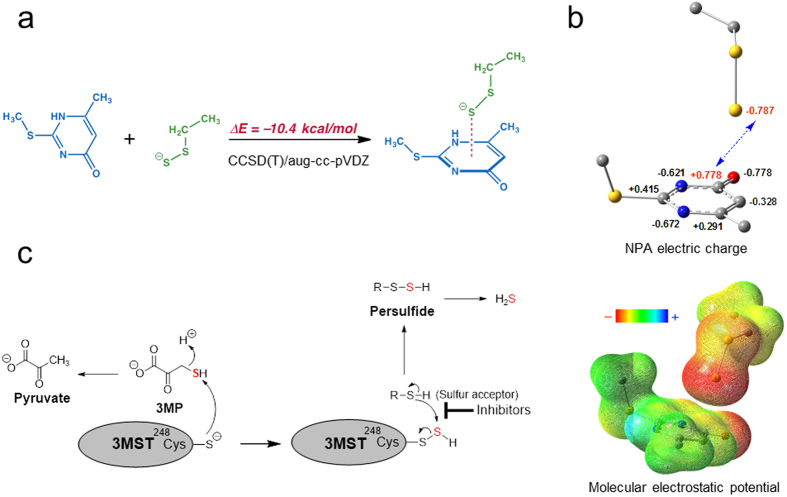
Molecular orbital calculation of interaction energy between persulfided cysteine residue and inhibitors.(a) Interaction energy calculation of model compounds by CCSD-T/AUG-CC-PVDZ. Calculated interaction energy was −10.4 kcal/mol and this interaction is highly stabilized. (b) Charge distribution of model persulfided molecule and pyrimidone structure. Strong electrostatic interaction was observed between these model molecules. (c) The putative enzymatic reaction mechanism of 3MST (the ping-pong mechanism) is shown. Persulfide or H2S is generated from 3MP via 3MST. The inhibitor found in this study blocks the second step of the enzymatic reaction, i.e., the transfer of a sulfur atom from the persulfurated cysteine residue at active site to an sulfur acceptor.